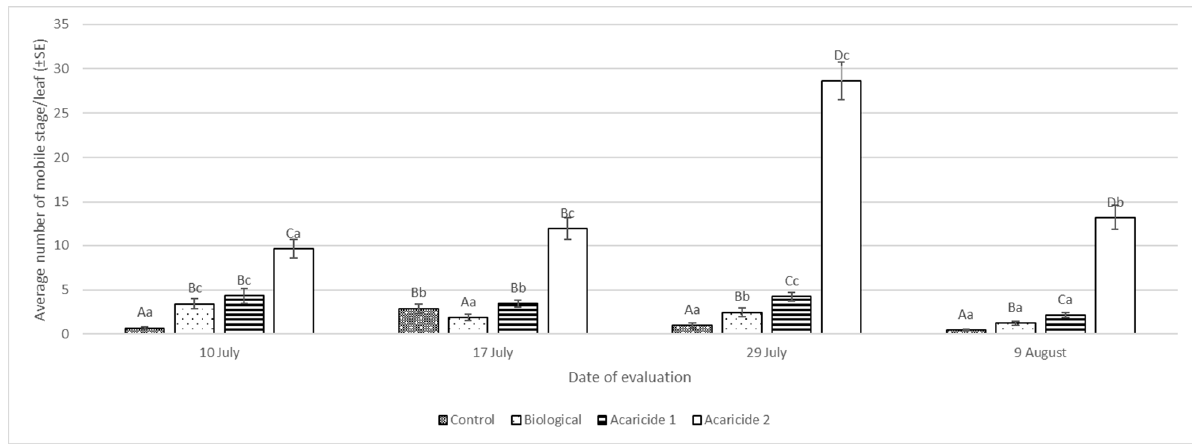
Figure 2. Average number of mobile stages of two-spotted spider mites per leaf (for comparison between dates of evaluation within specific treatment groups: lowercase letters; df = 3, 359; for control treatment, F = 25.23, p < 0.05; for biological control treatment, F = 37.25, p < 0.05; for Acaricide 1, F = 139.74, p < 0.05; for Acaricide 2, F = 67.73, p < 0.05). For comparison between treatments on a specific date of evaluation: uppercase letters; df = 3,359; for 10 July, F = 11.30, p < 0.05; for 17 July, F = 7.60, p = 0.2580; for 29 July, F = 3.23, p < 0.05; for 9 August, F = 44.98, p < 0.05).